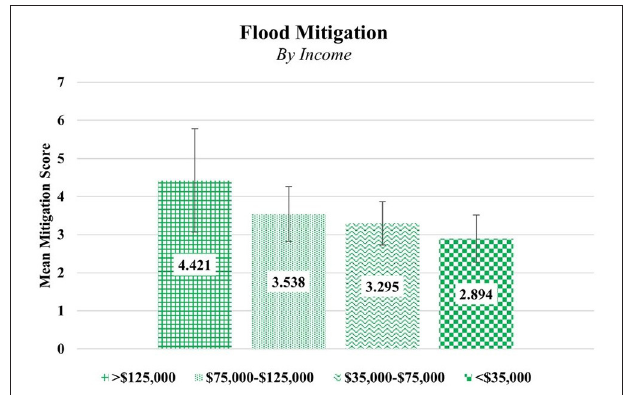
FIGURE 4 | Average mitigation actions by income.